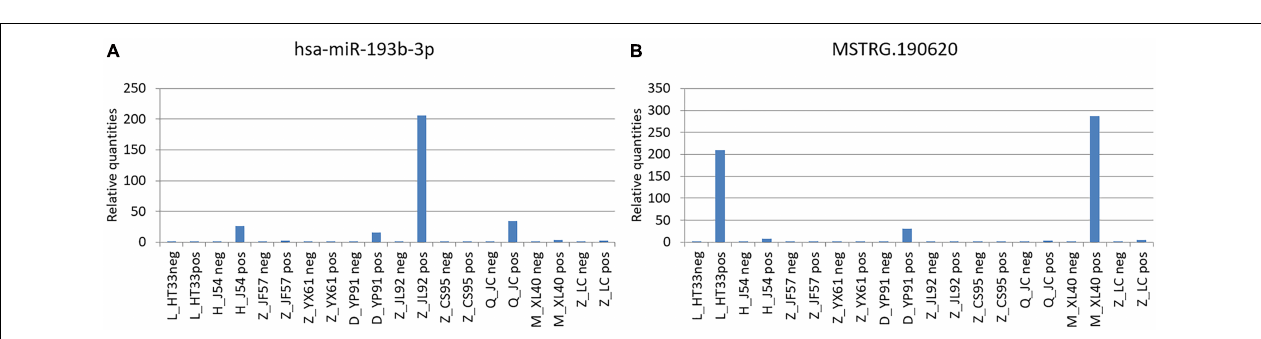
FIGURE 14 | Novel lncRNA MSTRG.190620 and miR-193b-3p constituted ceRNA of lncRNA–miRNA–mRNA. (A) miR-193b-3p was verified by PCR in MM. (B) Novel lncRNA MSTRG.190620 was verified by PCR in MM. The difference of the transcription level of target gene of each sample was calculated by 2– (cid:77)(cid:77) ct. The ordinate is the relative expression of the target gene in